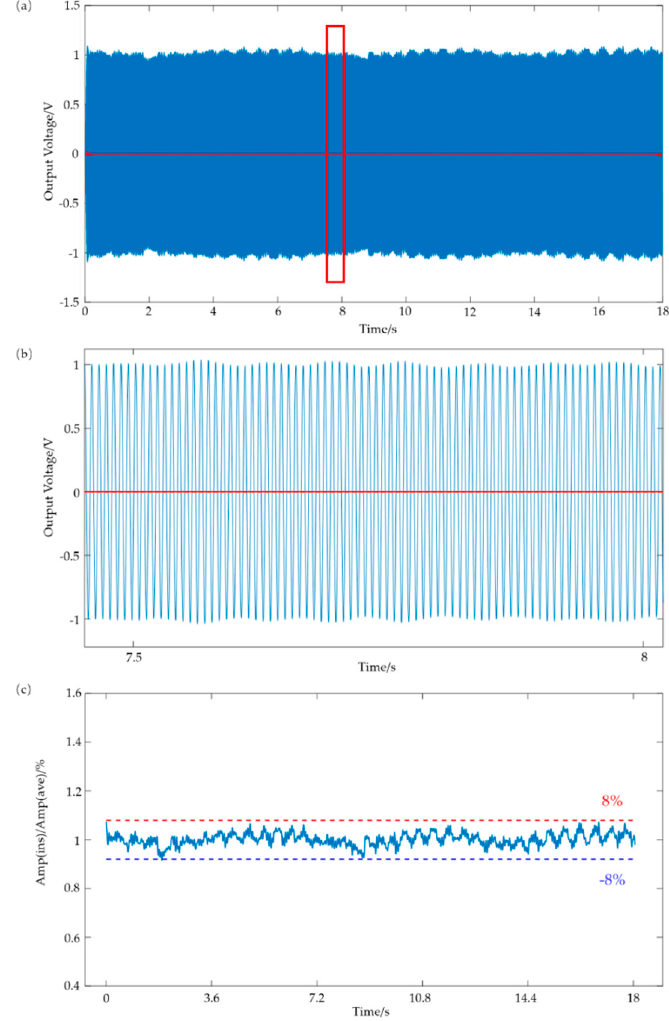
Figure 7. Schematic of the dynamic response of the flexible sensor. ( a ) Output voltage of the sensor versus time under a constant applied dynamic stimulus for 2500 cycles (frequency-140 Hz; SPL-95 dB). ( b ) Enlarged view of the output voltage waveform around 7.5–8 s. ( c ) The drift in Amp (ins) relative to Amp (ave).